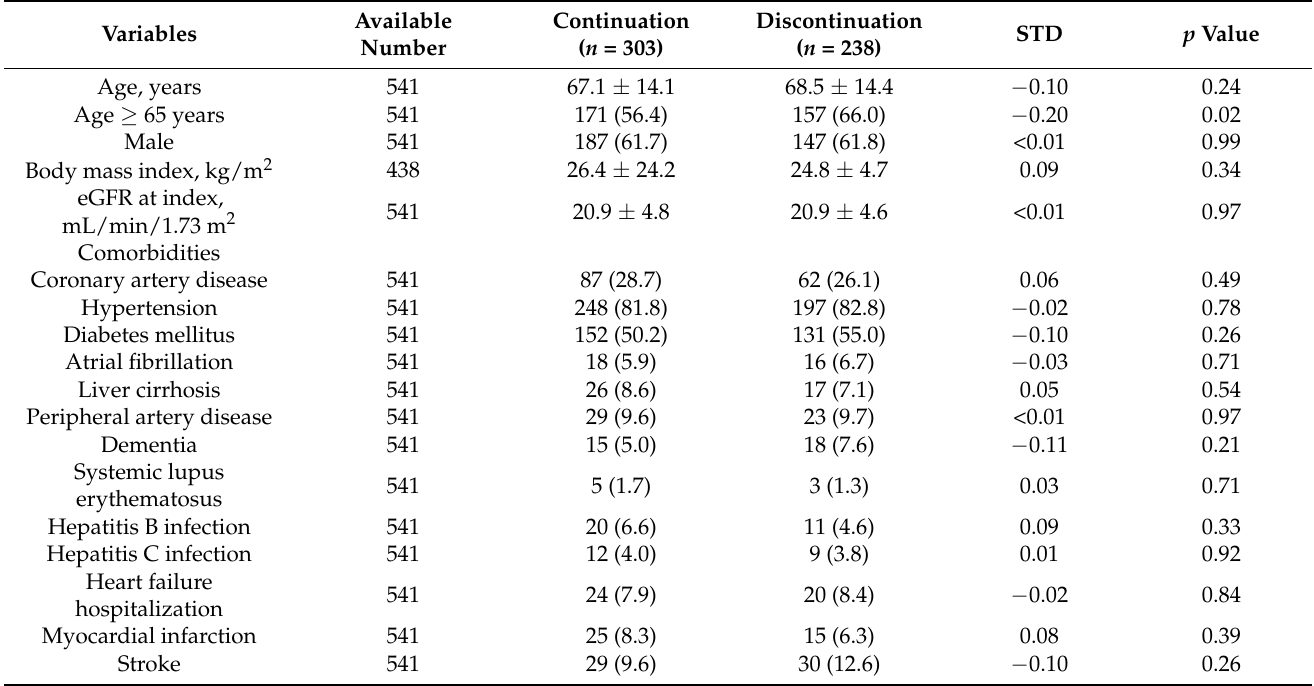
Table 1. Baseline characteristics of patients receiving ketoanalogues supplemental low protein diet before IPTW and EM